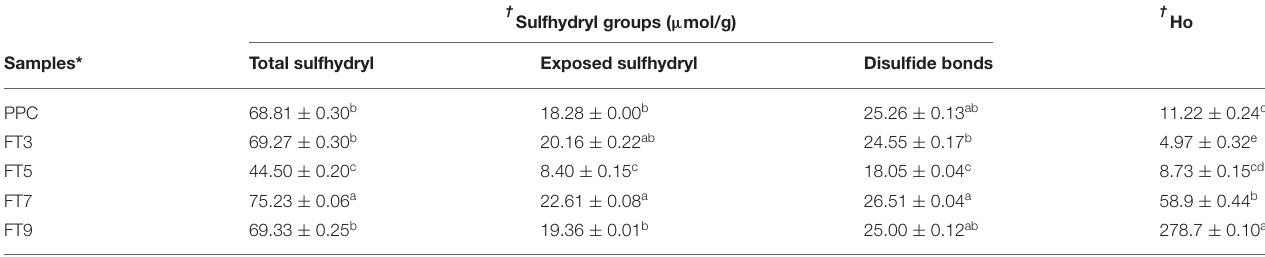
TABLE 2 | Sulfhydryl groups and surface hydrophobicity (H o ) of pea protein aggregates isolated by membrane ultrafiltration after heat treatment (100 ◦ C) at different pH